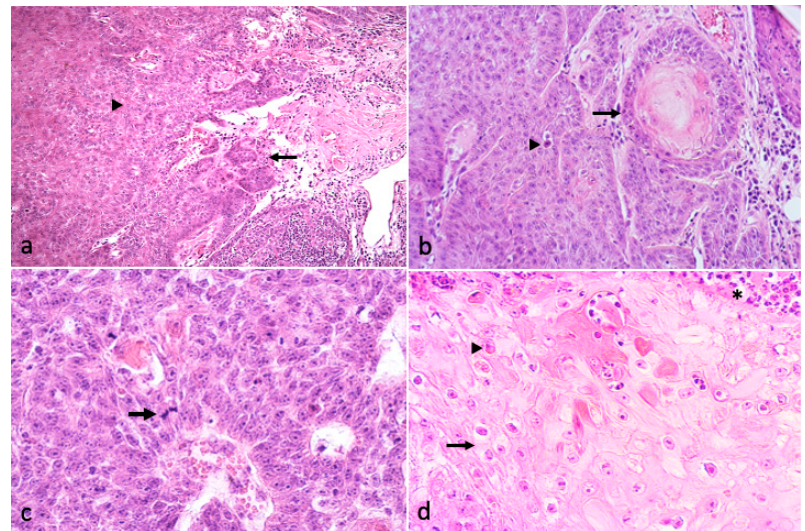
Figure 4. ( a ) Areas of the tumor showing a disorganized appearance and trabecular, papillar, or nest growth patterns (arrowhead). Papillary projections and nests of SCC invading the submucosa (arrow) (HE, 2.5 × ); ( b – d ) SCC cells showing mild to moderate pleomorphism, dyskeratinization, and keratin pearl formation (( b ), arrow. 20 × ), acantholytic cells (( b ), arrowhead), increased mitotic count (( c ), arrow. HE 40 × ), koilocytes (( d ), arrow), intranuclear inclusions (( d ), arrowhead), and foci of neutrophilic inflammation (( d ), asterisk. HE, 40 ×